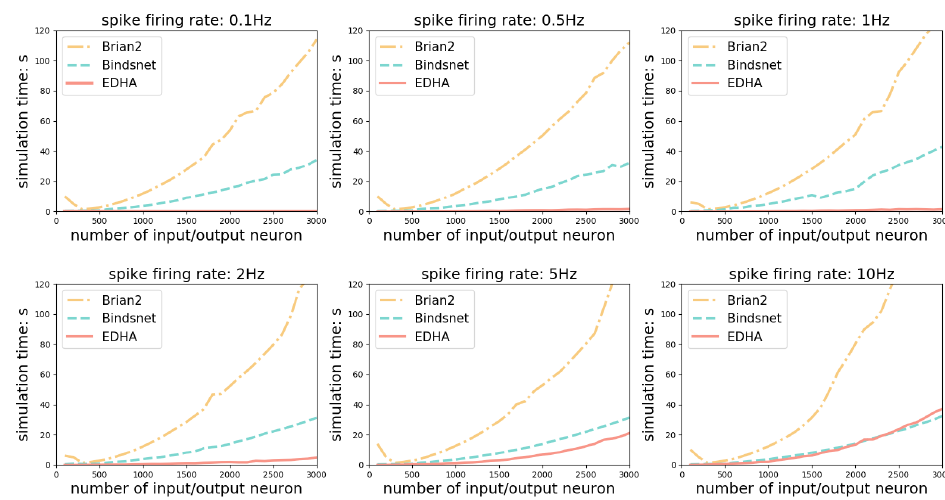
Figure 12. Benchmark simulation with learnable